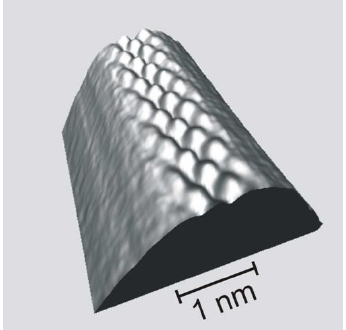
Figure 1. Atomic-resolution AFM topography of a single-walled carbon nanotube (SWNT) with a well-defined radius R o = 6.9 ± 0.1 Å in 3D view. The image size is 3 × 3 × 1 nm 3 . The atomically resolved depressing and protruding features are observed on the topmost part of a convexly curved surface.